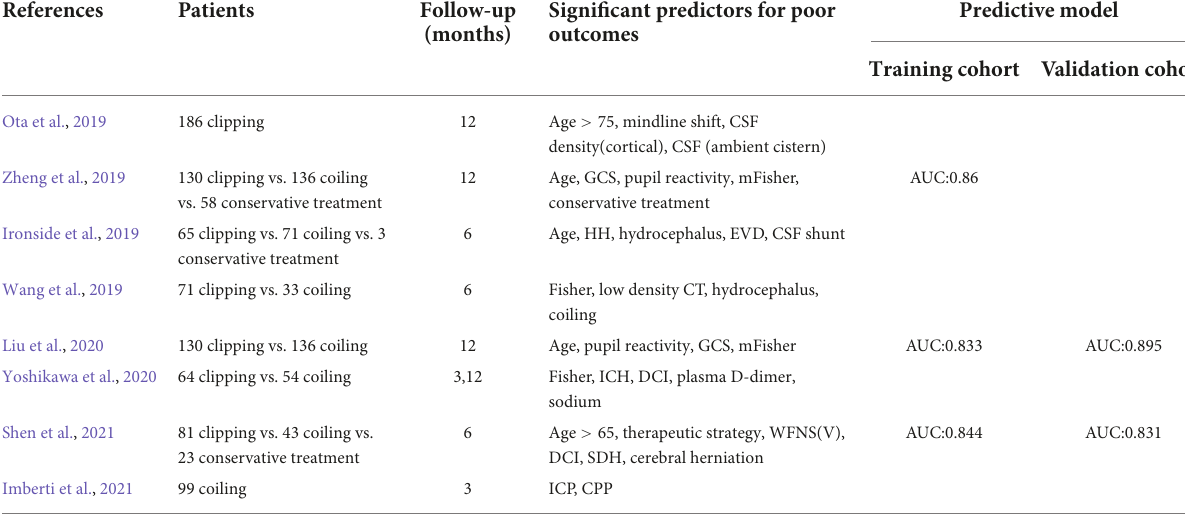
TABLE 4 A summary of studies on the significant predictors for poor outcomes in poor-grade SAH patients (WFNS